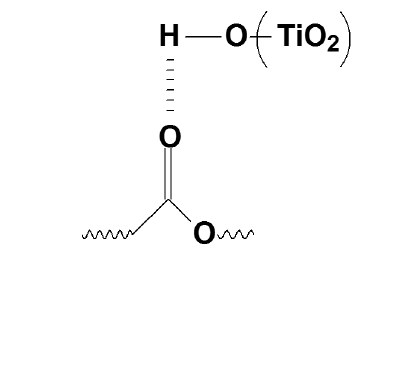
Scheme 1. Representation of the interaction